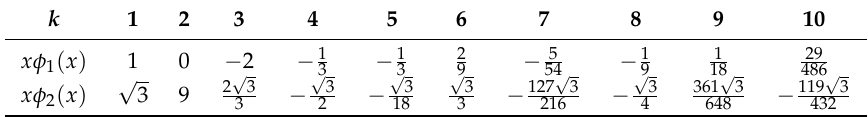
Table 2. The differential transform of x φ i ( x ) , i = 1,2 for Example